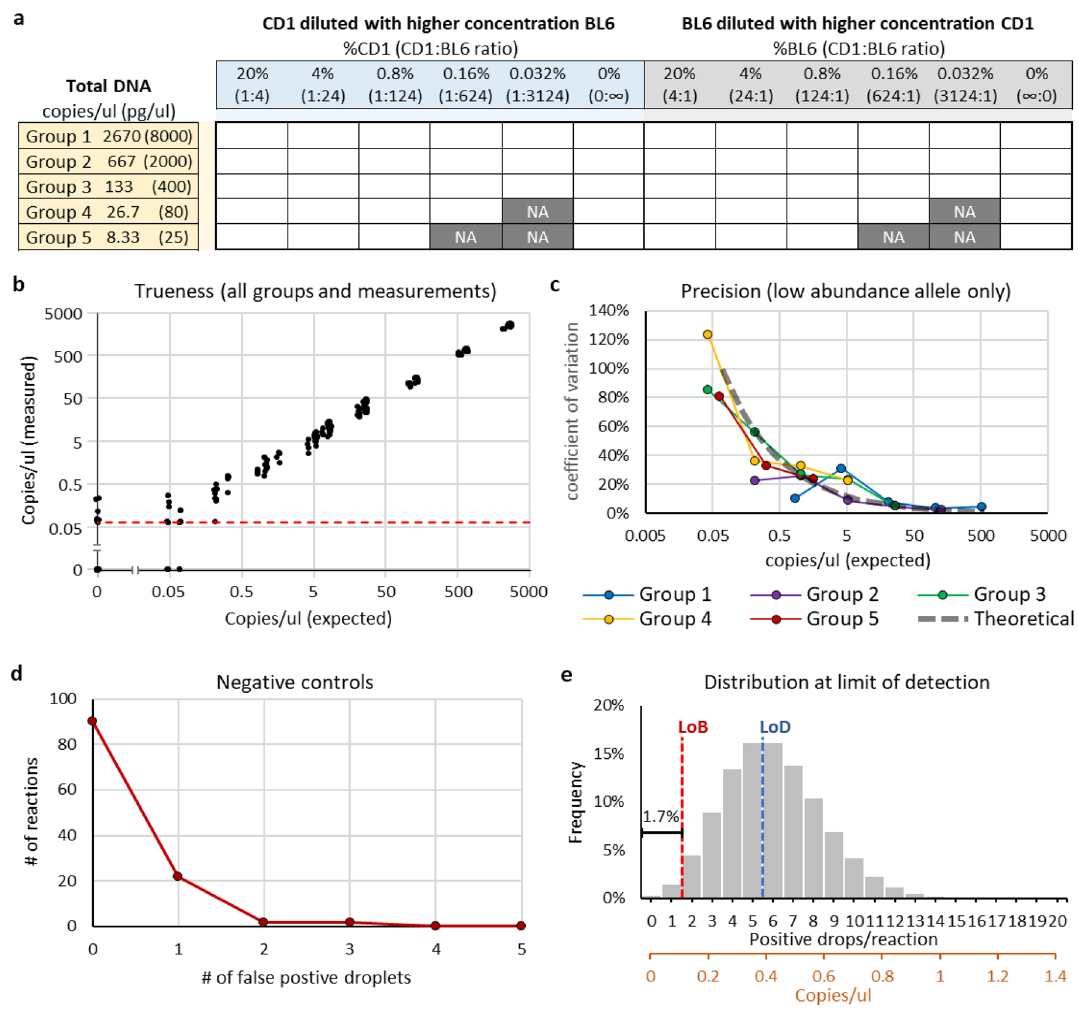
Figure 3. Trueness and precision at various dilutions. ( a ) Dilution table of CD1 and BL6 genomic DNA mixtures. Total DNA concentration was the same for each group. Dark gray boxes labeled NA were not analyzed because the concentration of low-abundance DNA was less than 0.5 molecules per reaction. ( b ) Combined Groups 1–5 concentration measurements compared to expected concentration; axes are log-scaled. 5% random error added to each point to aid in distinguishing overlapped datapoints. The red dashed line indicates the concentration at which there is only a single positive droplet per reaction (single molecule detection limit). ( c ) Coeffecient of variation (CoV, standard deviation divided by mean) calculated for the low-abundance allele in Groups 1–5 (n = 4 for each point: combined low-abundance CD1 and BL6 measurements, and two replicates of each). Gray dashed bar approximates theoretical CoV from subsampling error. ( d ) The number of false positive droplets in negative controls (n = 116). ( e ) Theoretical Poisson distribution of measured concentration when a sample is prepared at the LoD (6 molecules per reaction). The red dashed line and the blue dashed line indicate LoB and LoD, respectively. Black x-axis shows concentration as positive drops/reaction; brown x-axis shows concentration as copies/µl (assume 17,000 total drops/reaction). Area to the left of the LoB is β error